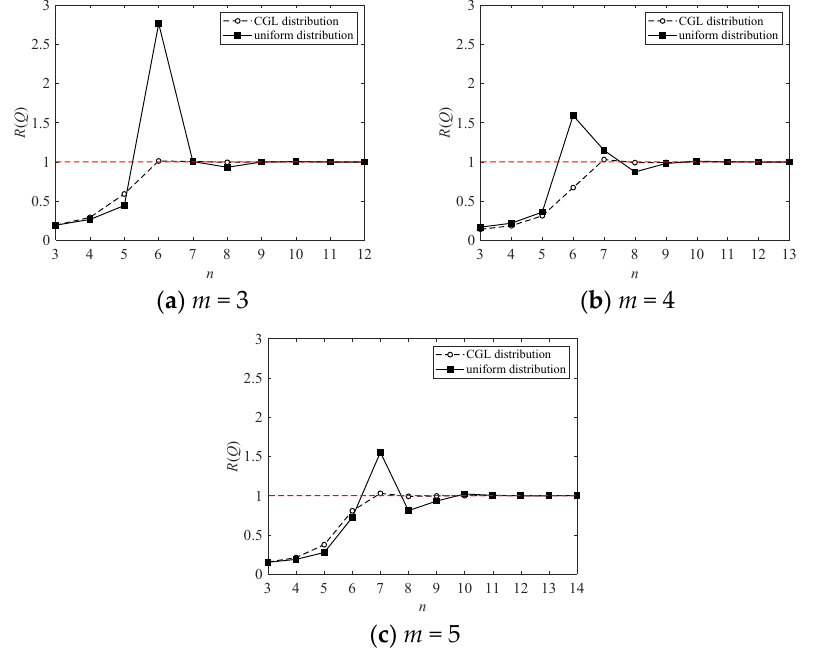
Figure 4. The relationship between spectral radius and mesh form.